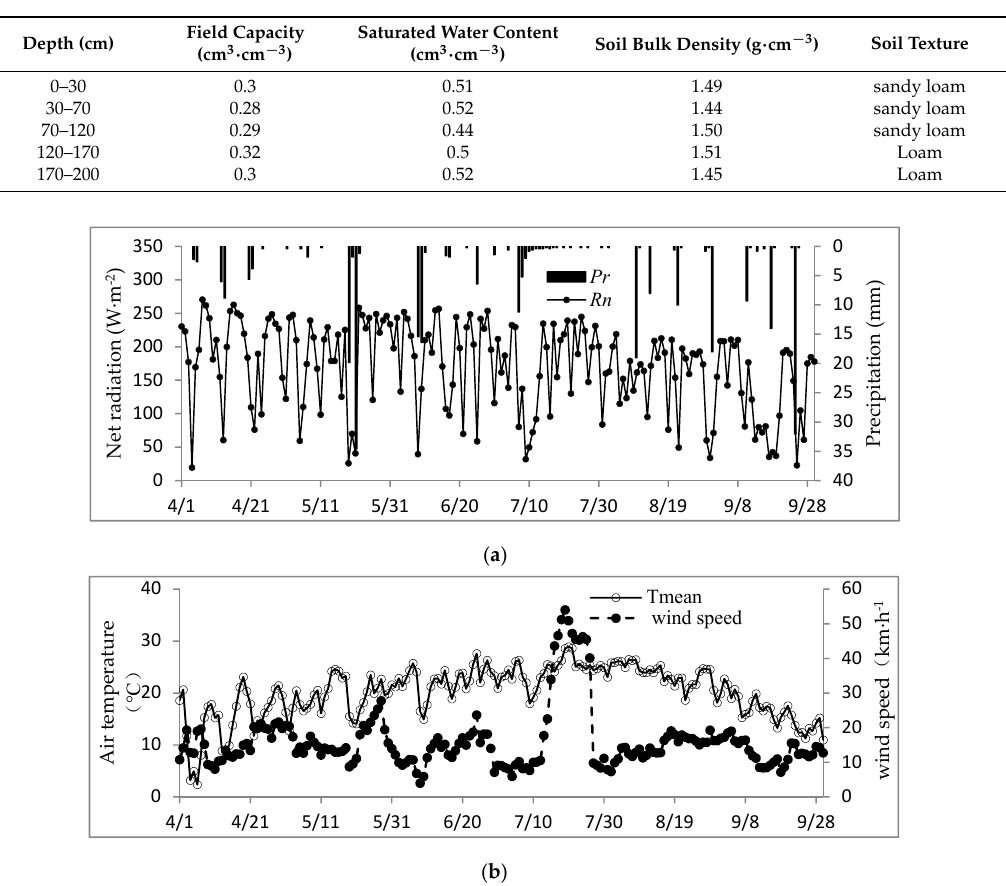
Figure 1. Diurnal variation of basic meteorological factors in apple growth season of 2018: ( a ) Description of net radiation ( R n ) and precipitation ( P r ); ( b ) Description of air temperature (T mean ) and wind speed ( v